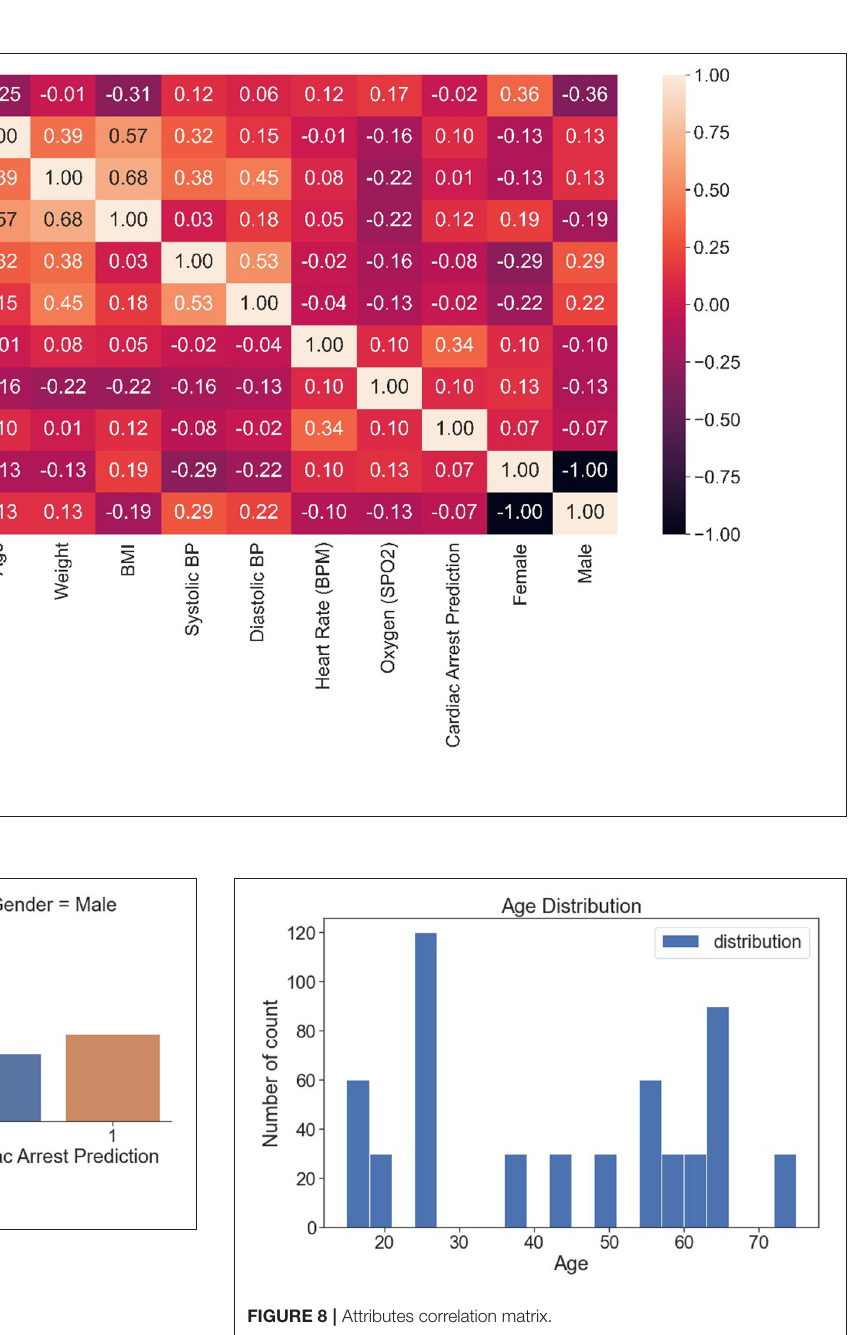
FIGURE 8 | Attributes correlation